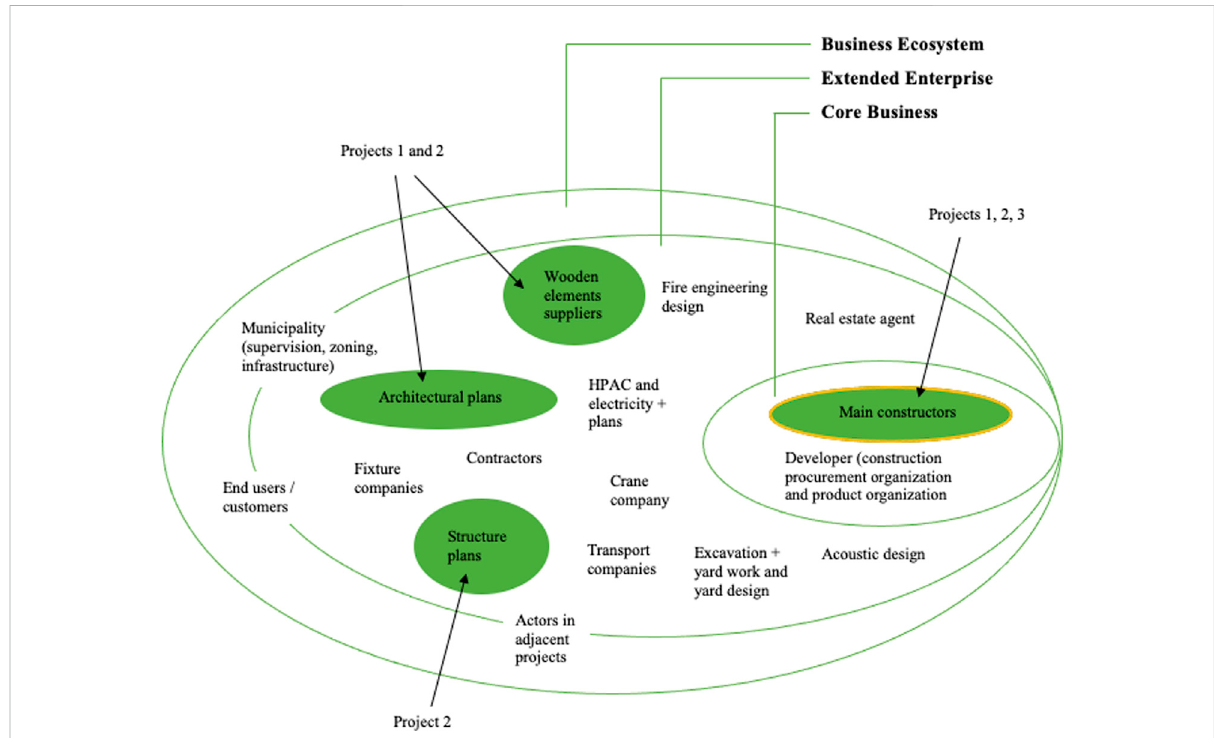
FIGURE 1 Identi fi ed project-based business ecosystem structure (participants included in direct interviews marked in green, the rest of participants were mentioned in